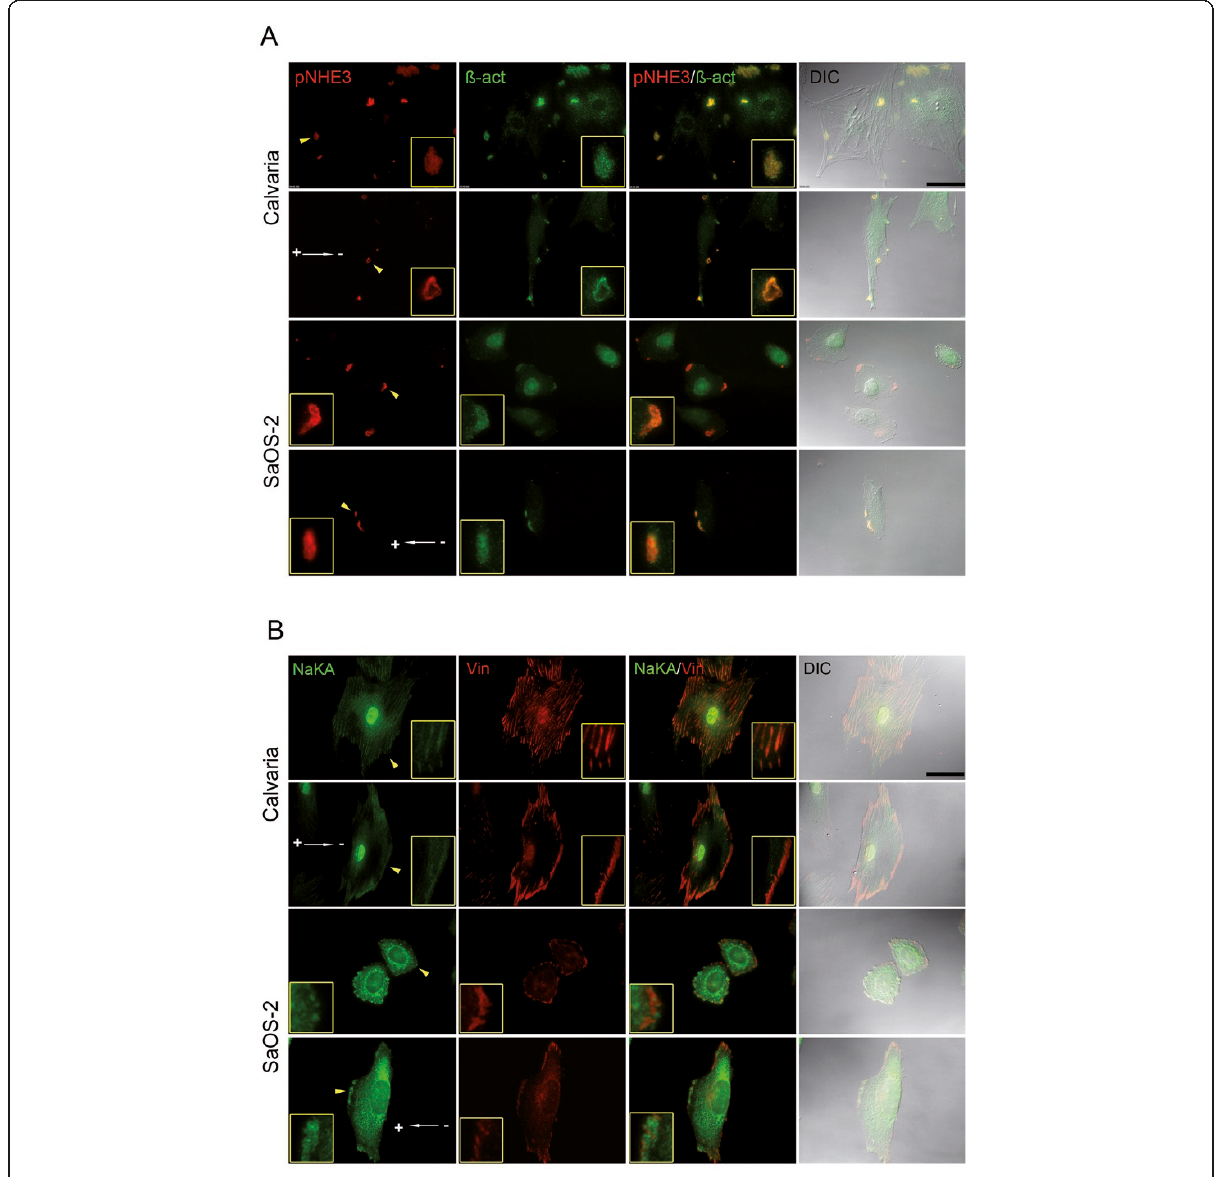
Figure 1 The localization of pNHE3 and of NaKA in EF-directed- versus random cellular movement . The colocalization of pNHE3 with ß- actin (A) and of NaKA with vinculin (B) on the leading edge of a cell in both cathode (Calvaria)- and anode (SaOS-2)-directed cells. First and third row: randomly migrating control cells. Second and fourth row: polarized cells that persist in a direction under an applied EF. White arrows with “ + ” and “ - ” poles indicate the migration direction under an applied EF. Yellow arrows indicate the magnified view and correspond to the entire row. Bar: 50 μ